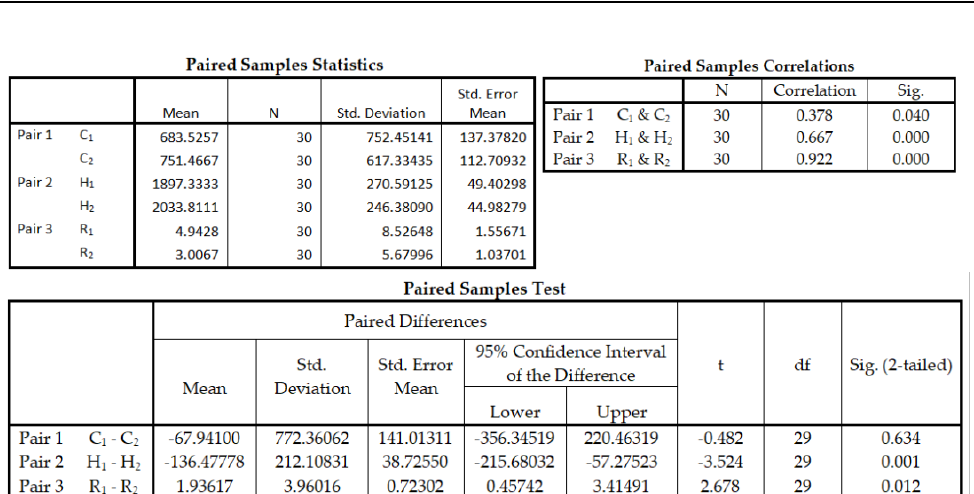
Figure 12. The results of the two-pair sample T test.